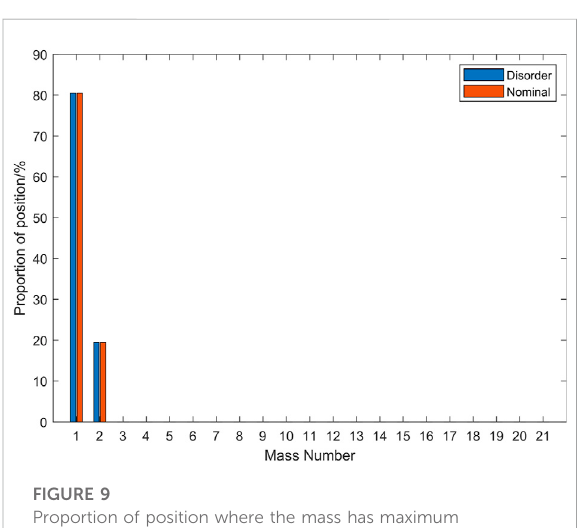
FIGURE 10 Positions where the mass has maximum displacement response inthetargetbandfor 200 samples. The yellow linerefers to the frequency, where the mass changes from the fi rst to the second for the nominal